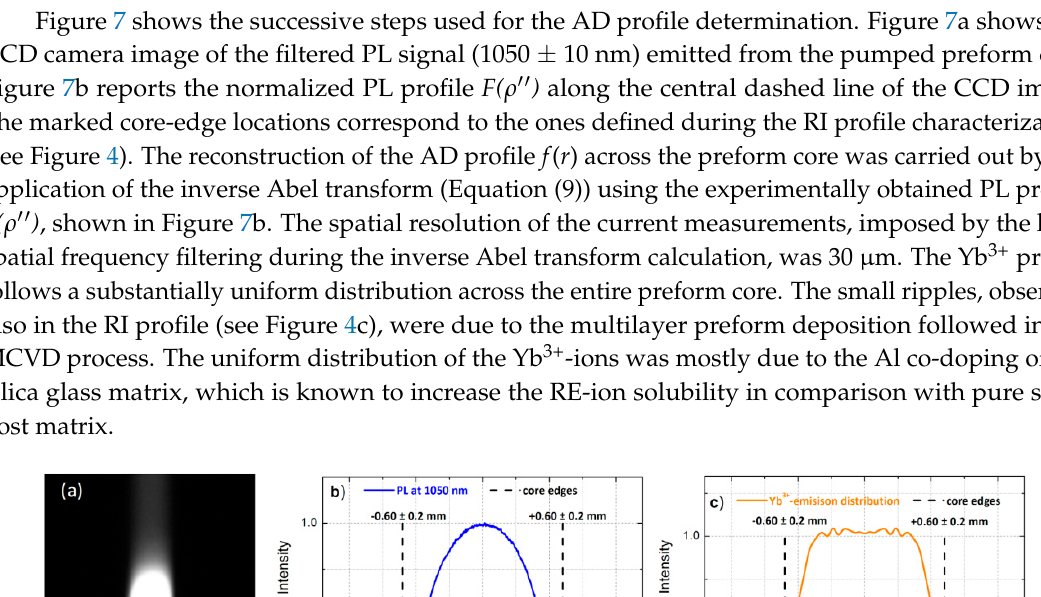
Figure 8. Comparison between the active-dopant profile obtained with the current method (red curve) and the profile measured by a SIMS analysis (blue curve). 4. Discussion The combined determination of the RI and AD profiles within optical preforms allows unambiguous definition of the core edge positions and places the AD distribution accurately within the optical core of the preform. This combined knowledge is particularly important for the